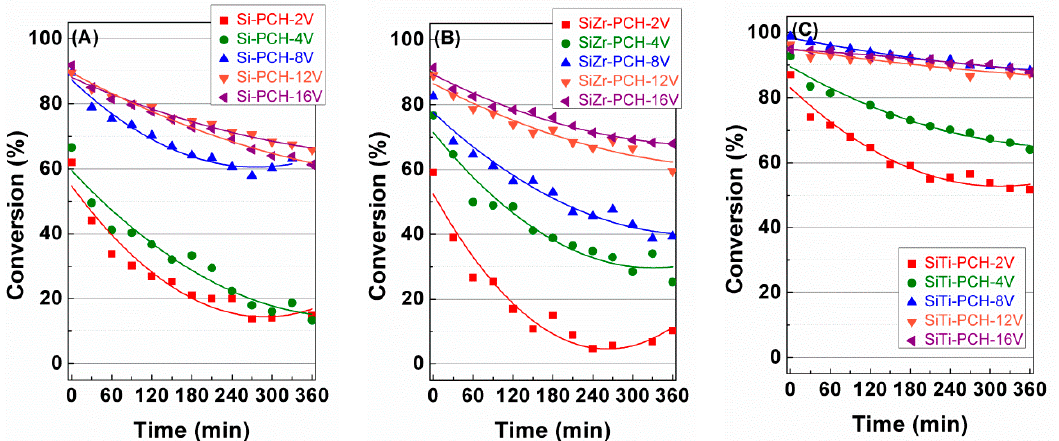
Figure 5. Variation of the H 2 S conversion with the time on stream (TOS) obtained for V-based catalysts supported on Si-PCH ( A ), SiZr-PCH ( B ) and SiTi-PCH ( C ). Reaction conditions: 0.05 g of catalyst; total flow of 130 mL min − 1 ; reaction temperature of 180 °C; H 2 S/air/He molar ratio of 1.2/5.0/93.8.